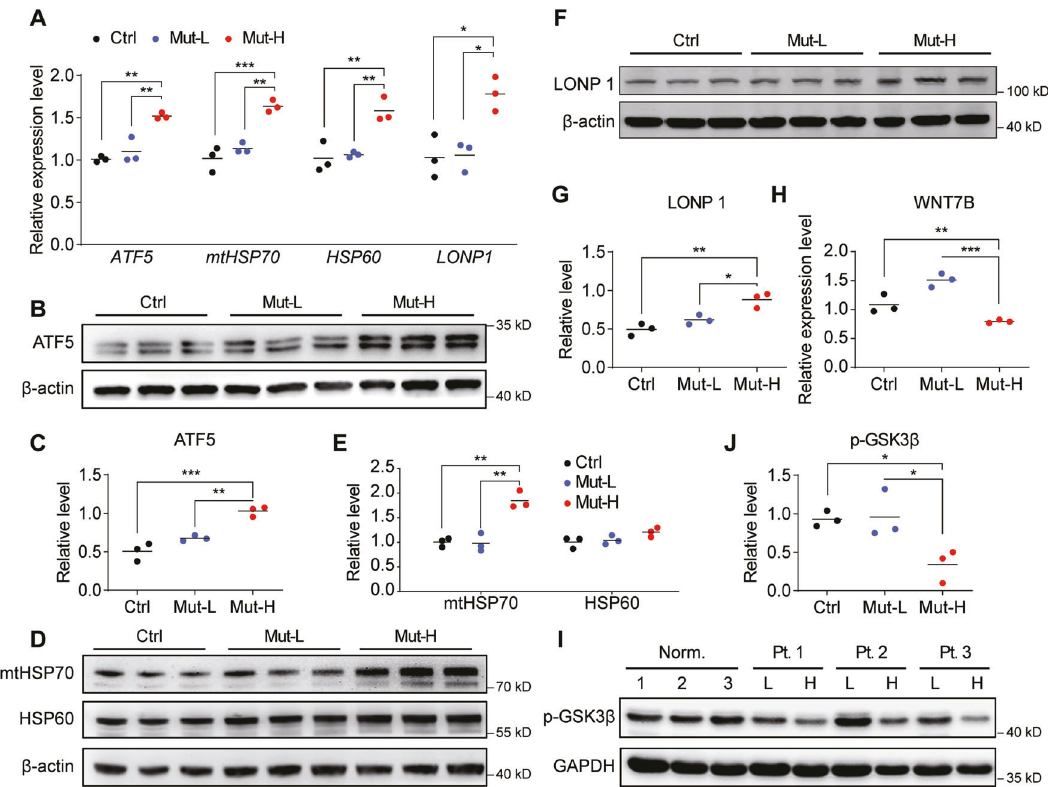
Fig. 4 Mut-H USCs had elevated UPR mt and reduced GSK3B and WNT7B. A The mRNA levels of UPR mt target genes ( ATF5, HSP70, HSP60 and LONP1 ) were elevated in Mut-H USCs. Total RNAs were extracted from Ctr, Mut-L and Mut-H USCs, and expression of UPR mt target genes were quanti fi ed through real-time quantitative PCR (RT-qPCR). B – G The protein levels of UPR mt target genes ( ATF5, HSP70, HSP60 and LONP1 ) were elevated in mutant-high USCs. Total protein lysates were extracted from USCs and protein levels were analyzed by western blot. β -actin served as internal loading control. C , E , G were quanti fi cation plot for B , D , F , respectively. H mRNA levels of WNT7B were reduced in Mut-H USCs. I Protein levels of p-GSK3 β were decreased in Mut-H USCs. GADPH serves as internal control. J Quanti fi cation plot for I . * P <0.05, ** P <0.01, *** P